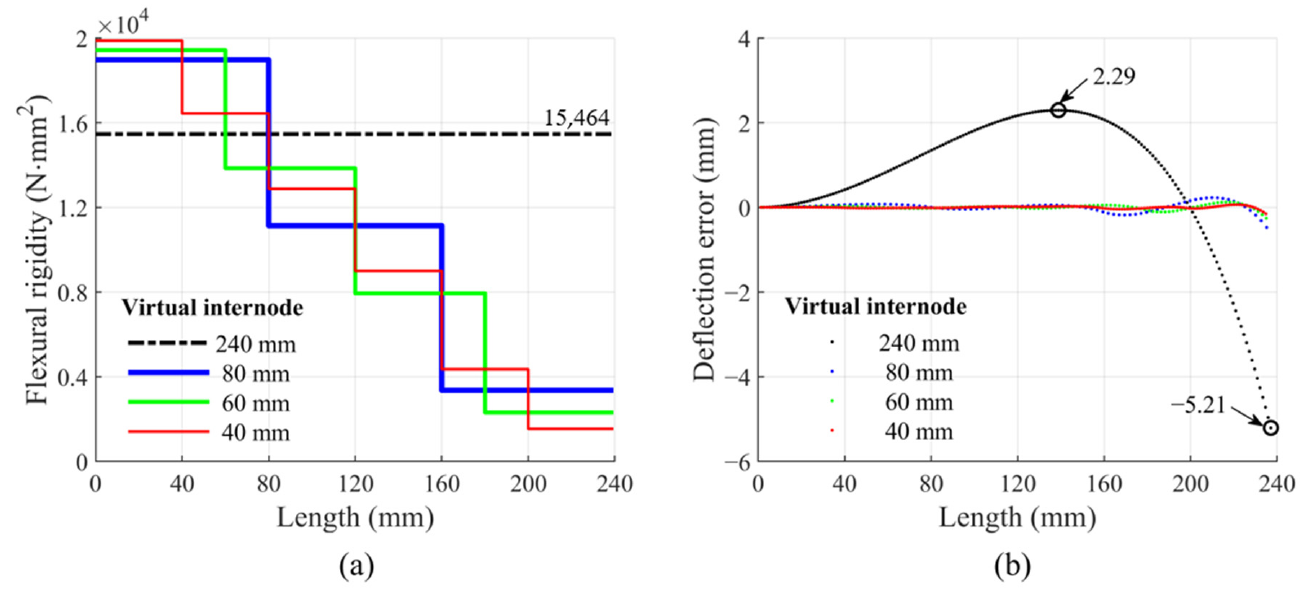
Figure 7. ( a ) Impact of length of virtual internode on flexural rigidity. ( b ) Impact of length of virtual internode on deflection error. The positive (negative) value represents that the calculated deflection is larger (smaller) than the observed deflection. The abscissa of two coordinate frames represents the length along the axial line of tea